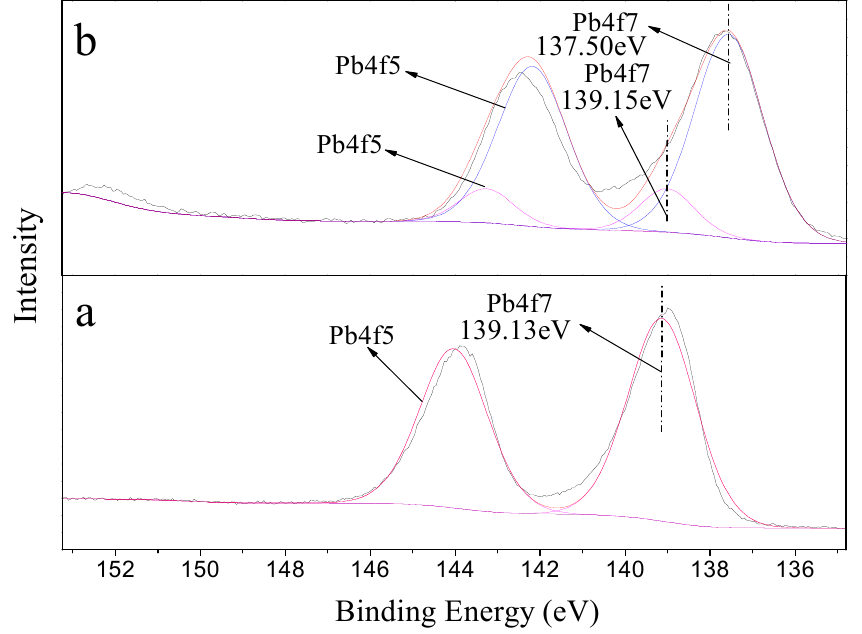
Figure 9. Pb4f X-ray photoelectron spectra for ( a ) hemimorphite + Pb 2+ and ( b ) hemimorphite + Pb 2+ + Na 2 S.